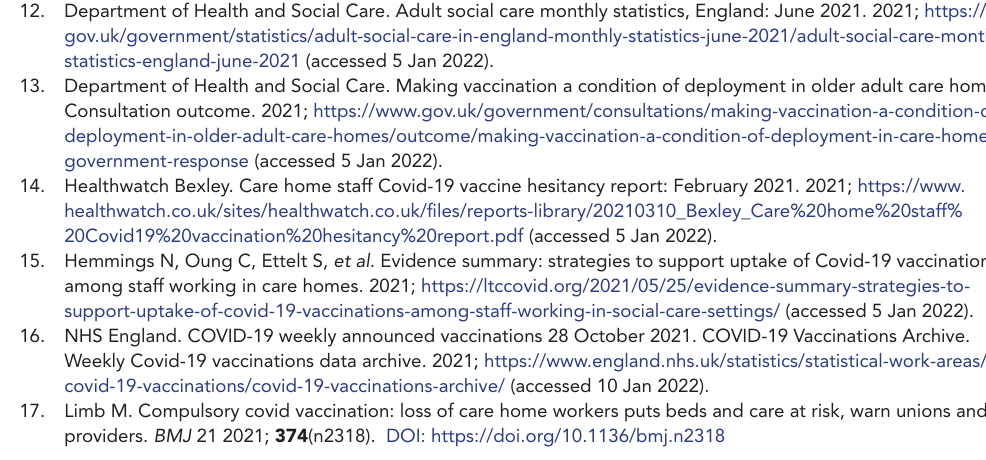
Swift P and Bunn L. BJGP Open 2022; DOI: